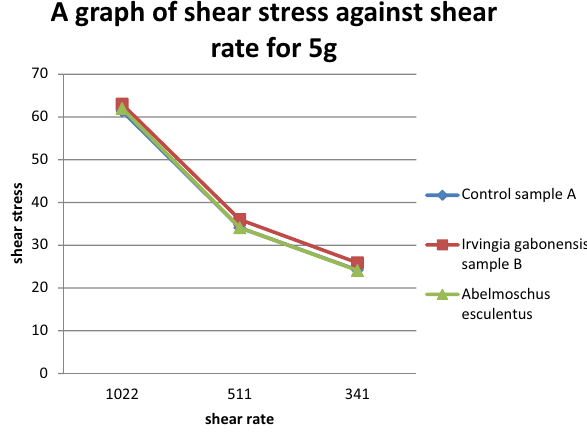
Fig. 6 Graph of shear stress against shear rate for 5